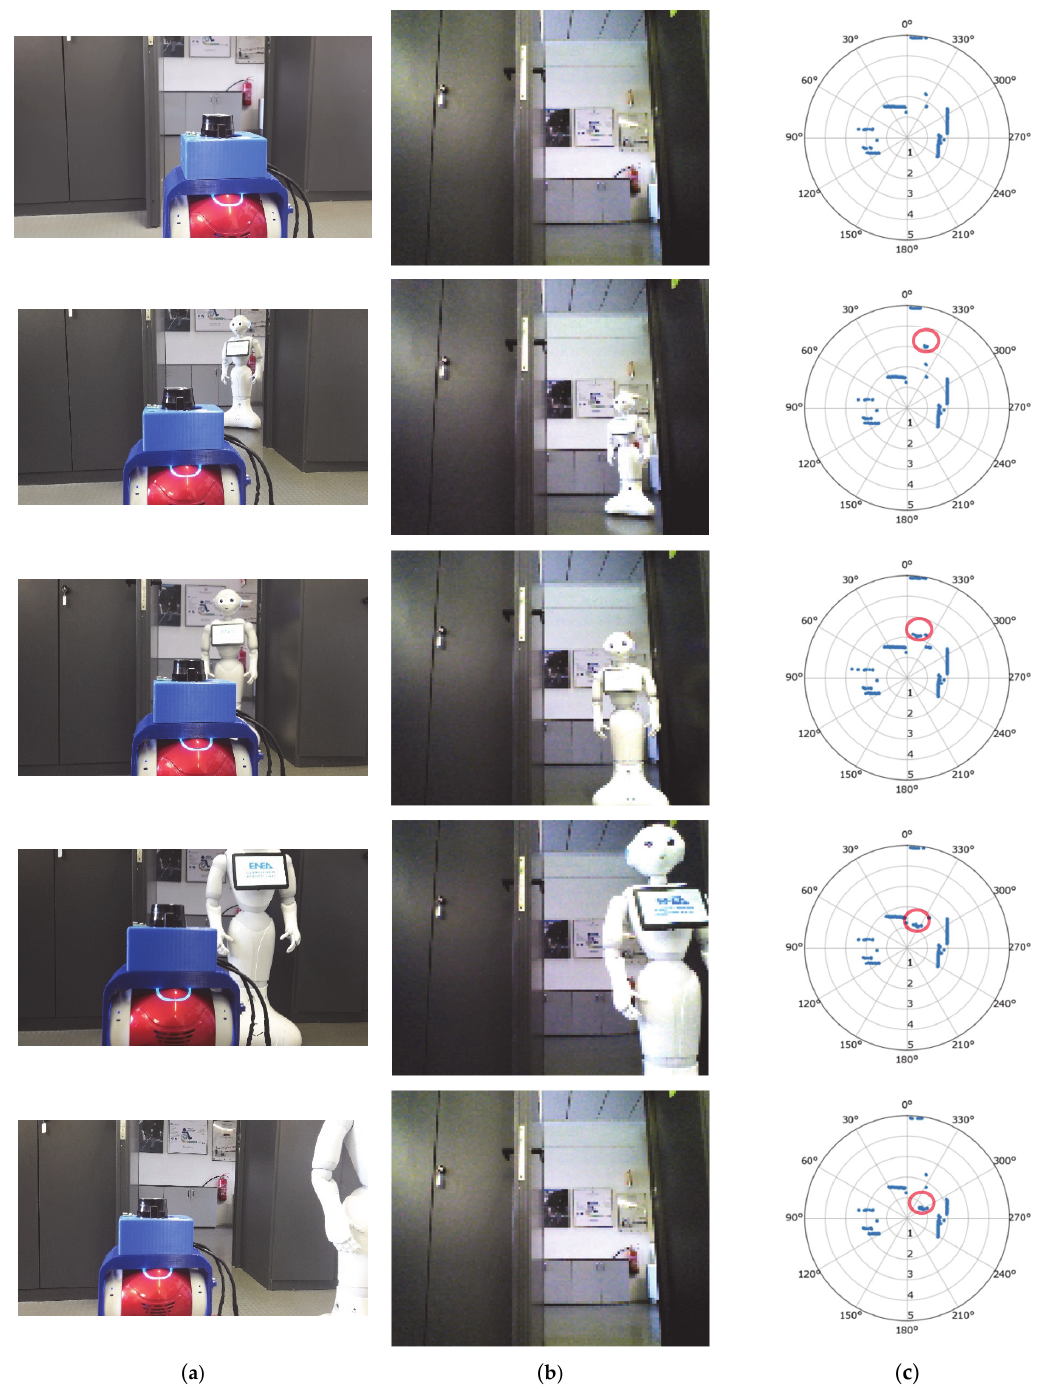
Figure 13. Test #2—scenario #2: ( a ) pictures taken by a camera located behind the NAO, ( b ) pictures taken by the robot’s camera; ( c ) polar diagram from the data acquired by the rangefinder device. The robot is located in the center of the diagram (coordinates 0,0) and oriented toward 0°. Circled in red is the position of the Pepper robot.